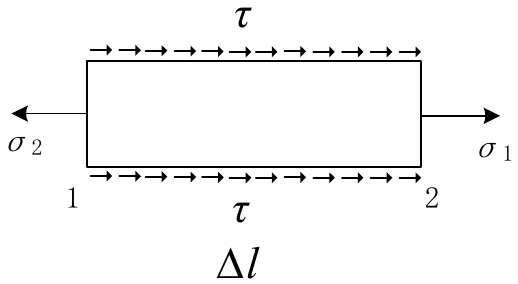
Figure 13. Stress diagram of reinforcement anchorage section.